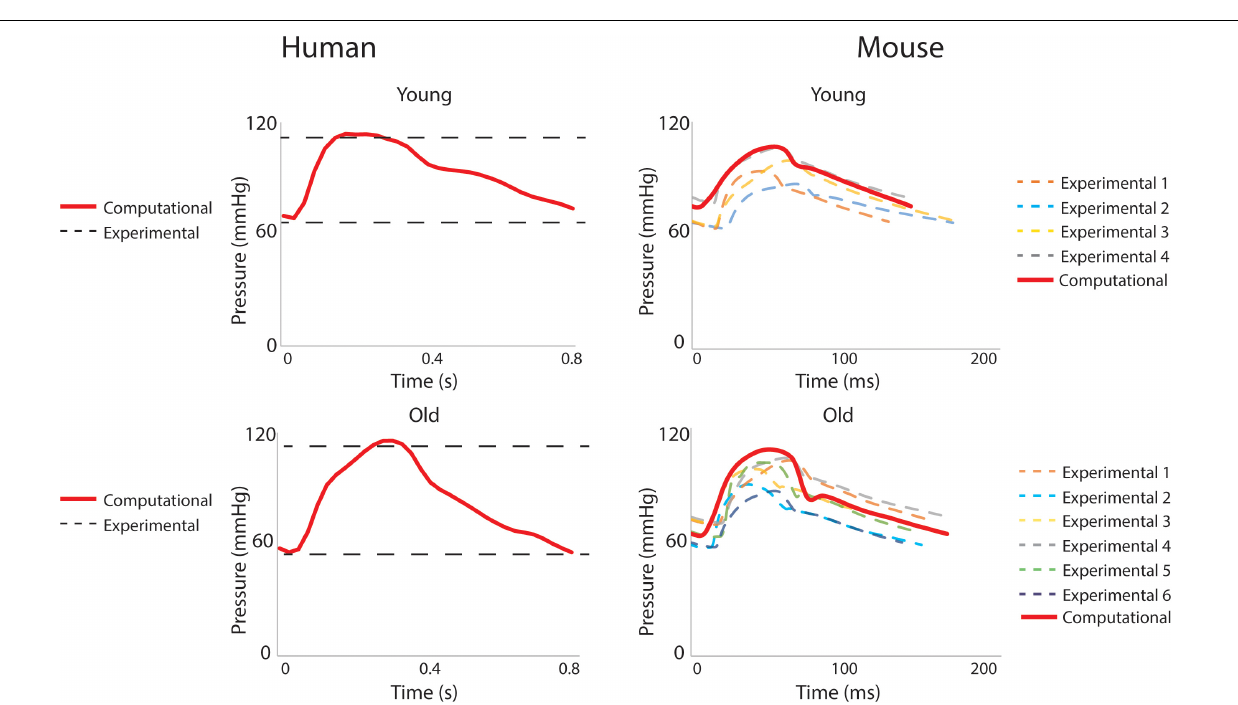
FIGURE 6 | Volume rendering of blood velocity at peak systole for the humans (left) and mice (right), with pressure and flow waveforms at three sites along the aorta (ATA, ascending thoracic aorta; DTA, descending thoracic aorta; and IAA, infrarenal abdominal aorta) (center).